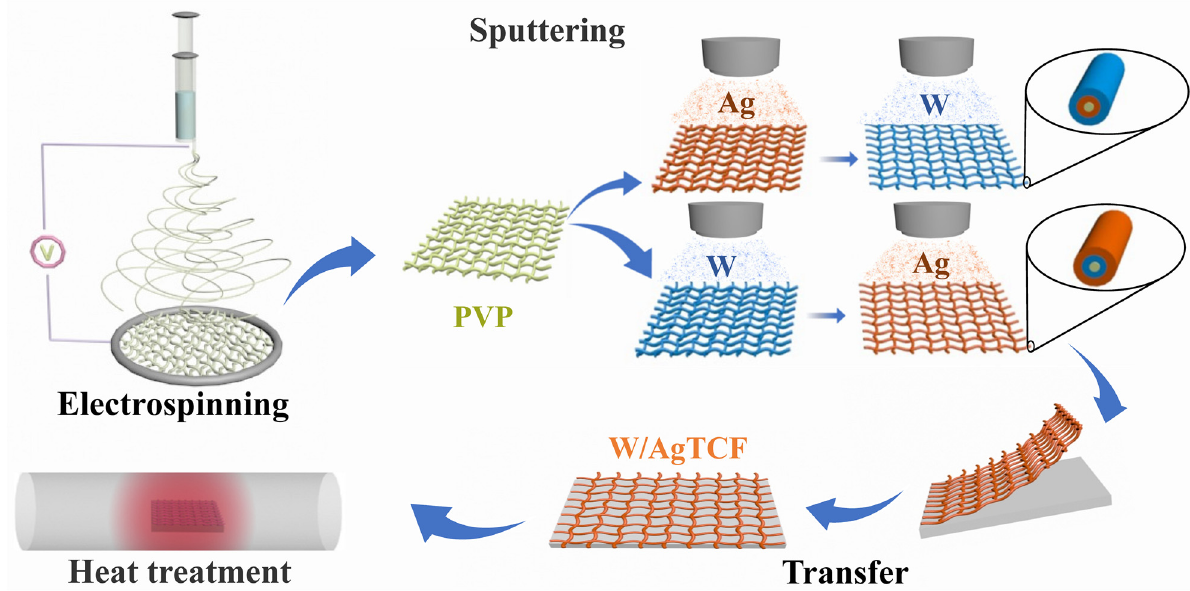
Figure 1. Schematic diagram of the experimental flow for the preparation of W/Ag (or Ag/W) composite nanonetwork TCFs.